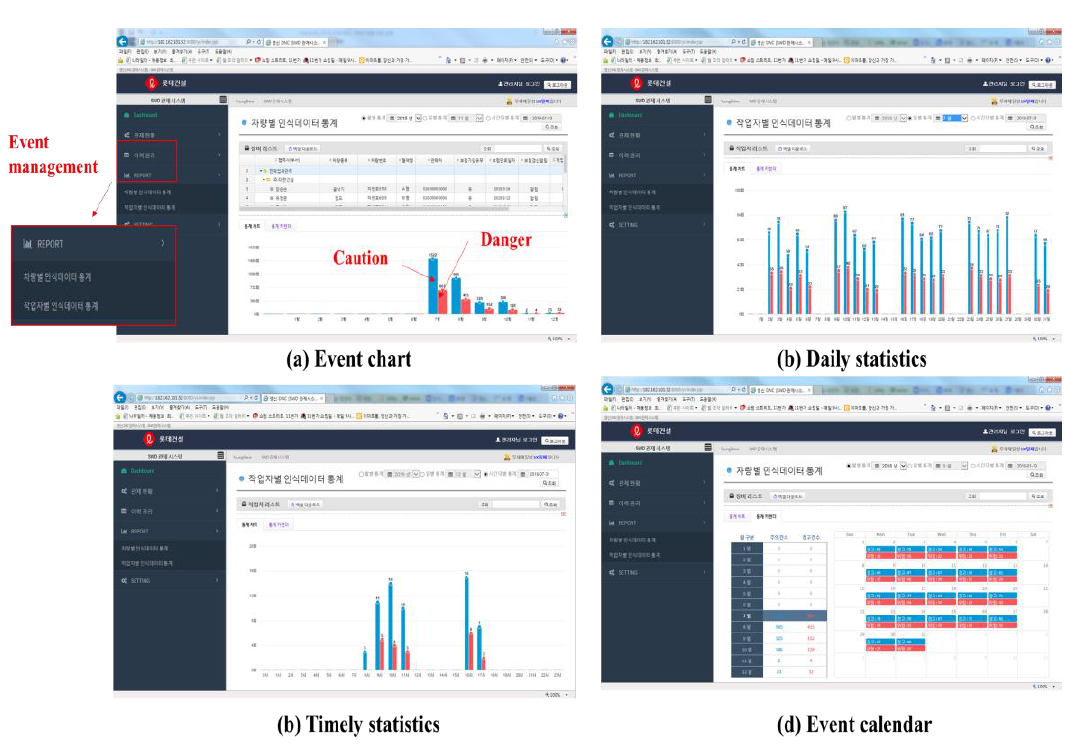
Figure 20. Resource management.